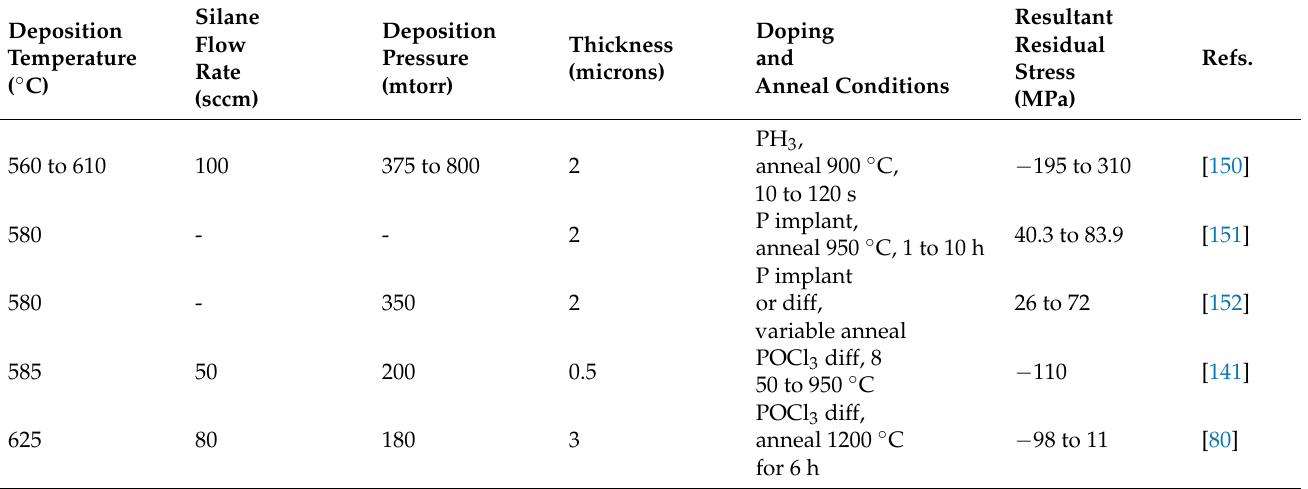
Table 21. Residual Stress in Doped LPCVD Polysilicon Thin-Film Material Layers After High- Temperature